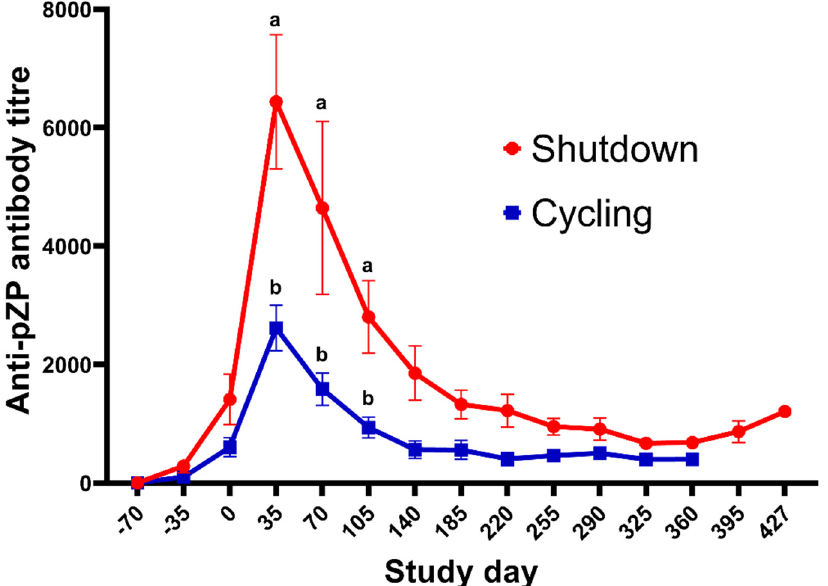
Figure 4. Mean ( ± SEM) anti-pZP antibody titres ( ± standard error) of jennies vaccinated with reZP or pZP presenting with ( n = 8) or without ( n = 7) ovarian shutdown. Day 0 = day of last immunisation. Jennies were vaccinated with three doses of reZP on Days − 70, − 35 and 0. For pZP, the primary dose and the booster were administered on Days − 35 and 0. Superscript letters ( a,b ) denote significant difference between jennies with or without ovarian shutdown ( p < 0.05).